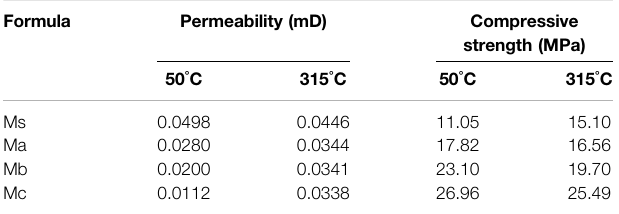
TABLE 4 | In fl uence of slag on the high temperature resistance of aluminate cement stone. Formula